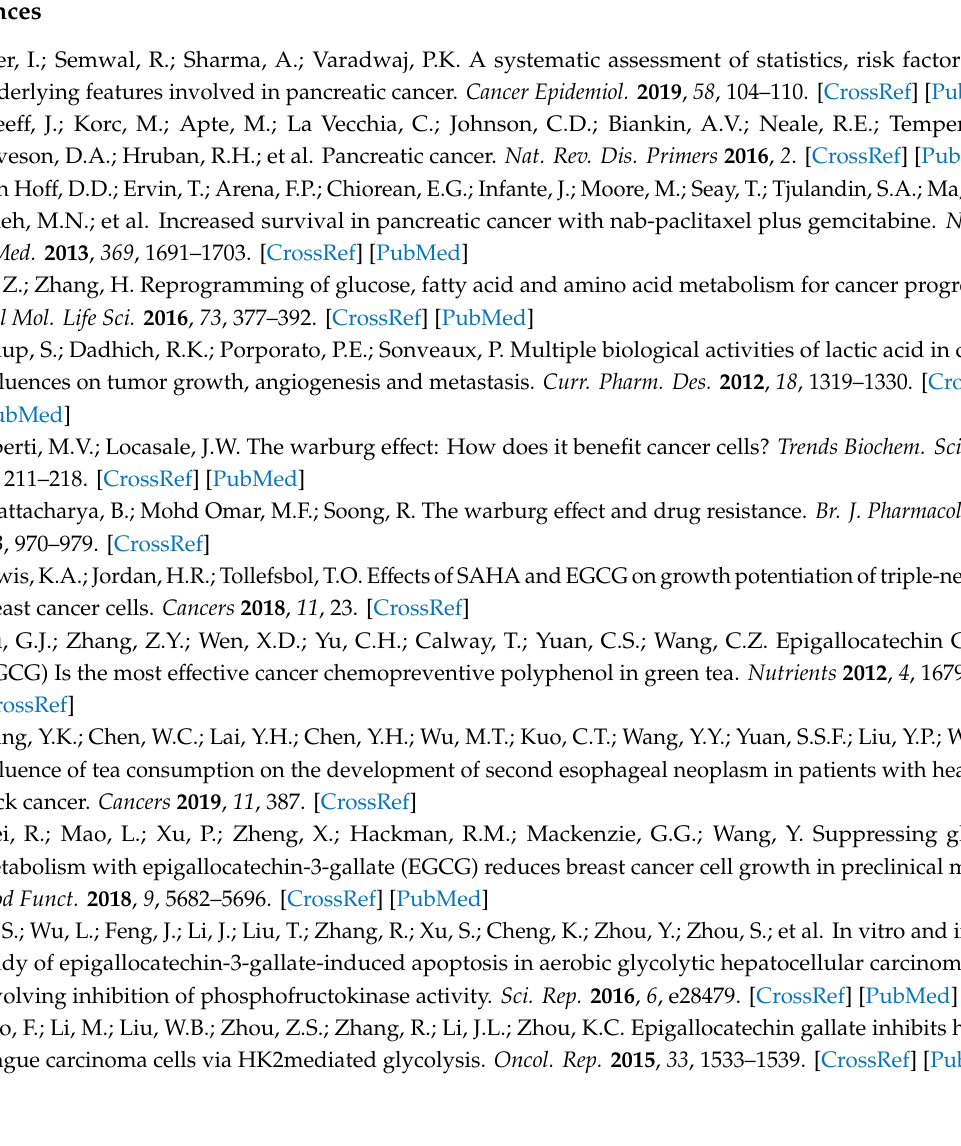
treated groups. Figure S4. Western blot images with molecular weight for PFKP and PKM2 shown in Figure 2B. Figure S5. Western blot images with molecular weight for PFKP and PKM2 shown in Figure 2C. Figure S6. Western blot images with molecular weight for PFKP and PKM2 shown in Figures 2D and 2E. Figure S7. Western blot images with molecular weight for PFKP and PKM2 shown in Figure 3D. Figure S8. Western blot images with molecular weight for p-Chk1, p53, p21, cdc2 and CyclinB1 shown in Figure 6B. Figure S9. Western blot images with molecular weight for Caspase 3, Caspase 7, Caspase 9 and PARP shown in Figure 6D. Figure S10. Western blot images with molecular weight for Bcl-xl, Bad, XIAP, Survivin shown in Figure 6E. Figure S11. Western blot images with molecular weight for PFKP and PKM2 shown in Figure 7B. Figure S12. Western blot images with molecular weight for HK2 and LDHA shown in Figure